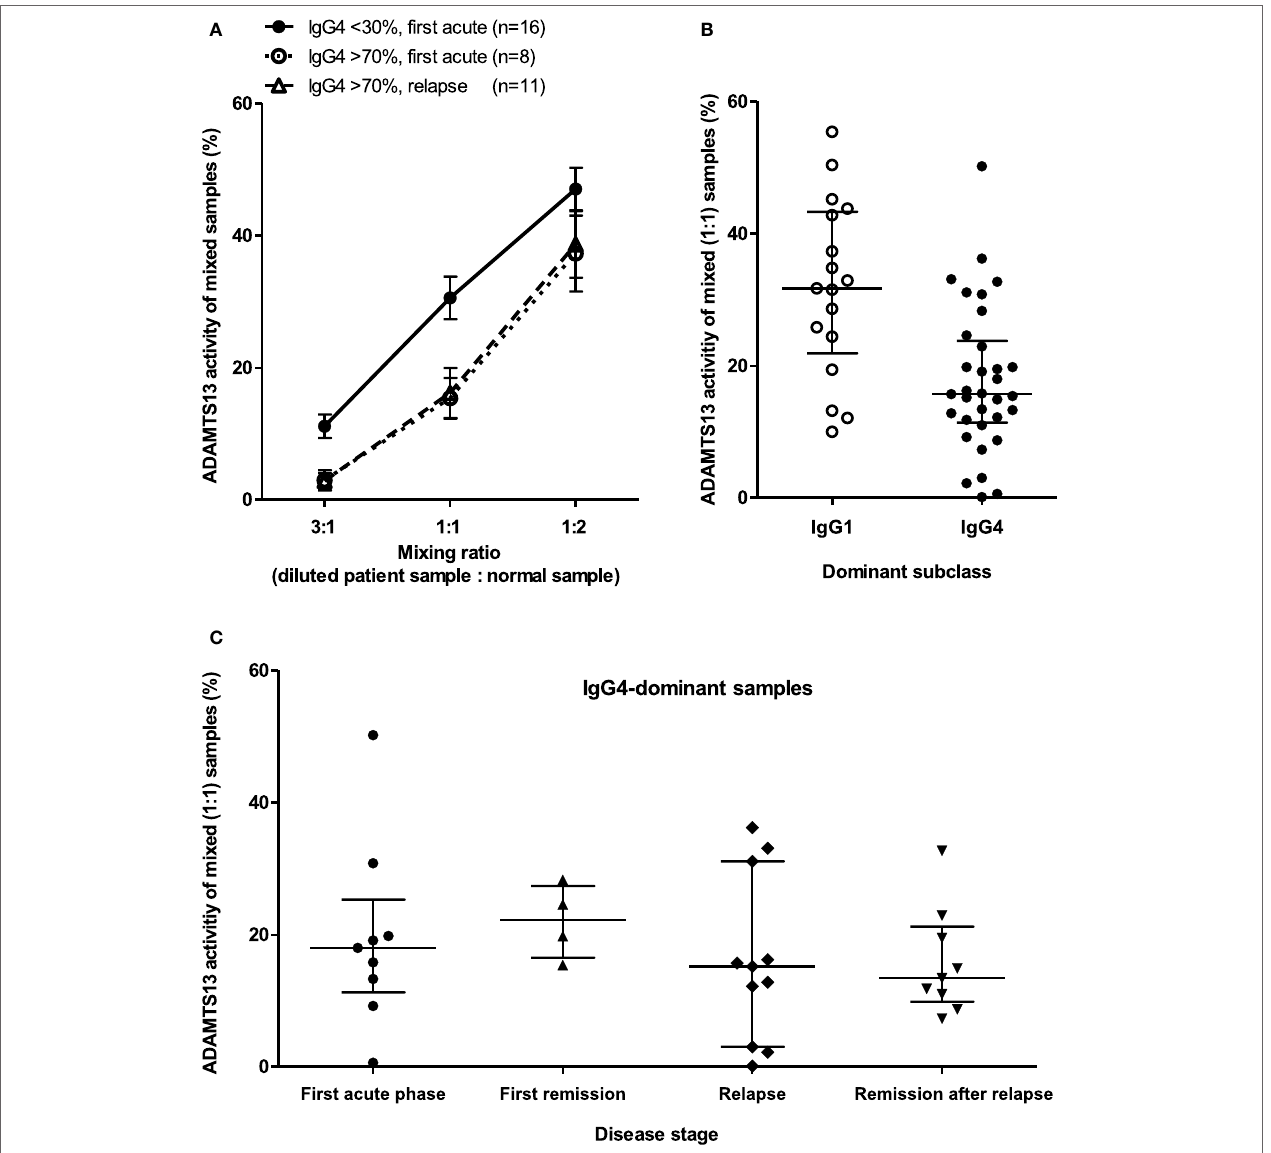
FigUre 6 | Specific inhibitory potentials of samples from different disease stages and with different IgG4 proportions. Patient samples were diluted in order to have equal (25 U/mL) anti-ADAMTS13 concentrations, diluted samples were mixed and incubated in different ratios with normal pooled human citrated plasma or serum, and ADAMTS13 activities of the mixed samples were measured. Low activities of mixed samples indicate a strong inhibitory potential and vice versa . (a) Specific inhibitory potentials of acute samples. Mean and SEM are shown for all mixing ratios. All deficient samples from the relapse phase were IgG4 dominant; none had IgG4 proportions below 30%. (B) Specific inhibitory potentials of all samples stratified by dominant IgG subclass. (c) Specific inhibitory potentials of IgG4 dominant samples stratified by disease stage. All deficient samples taken during or following a relapse were IgG4